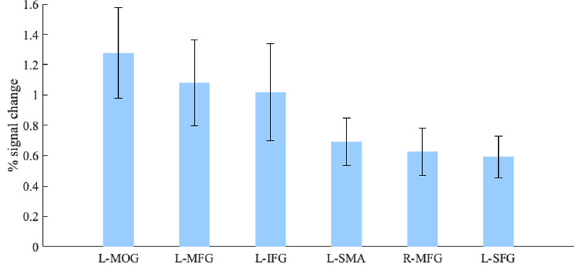
Fig. 5 The contrast incongruent > congruent statements in physics displayed with plots of the percentage BOLD signal change from the peak voxels ( p UNCORRECTED < 0.005; L left hemi- sphere, R right hemisphere). Error bars represent SE. L left, R right, MOG middle occipital gyrus, MFG middle frontal gyrus, IFG inferior frontal gyrus, SMA supplementary motor area, SFG superior frontal gyrus. Error bars represent one SEM (standard error of the mean).